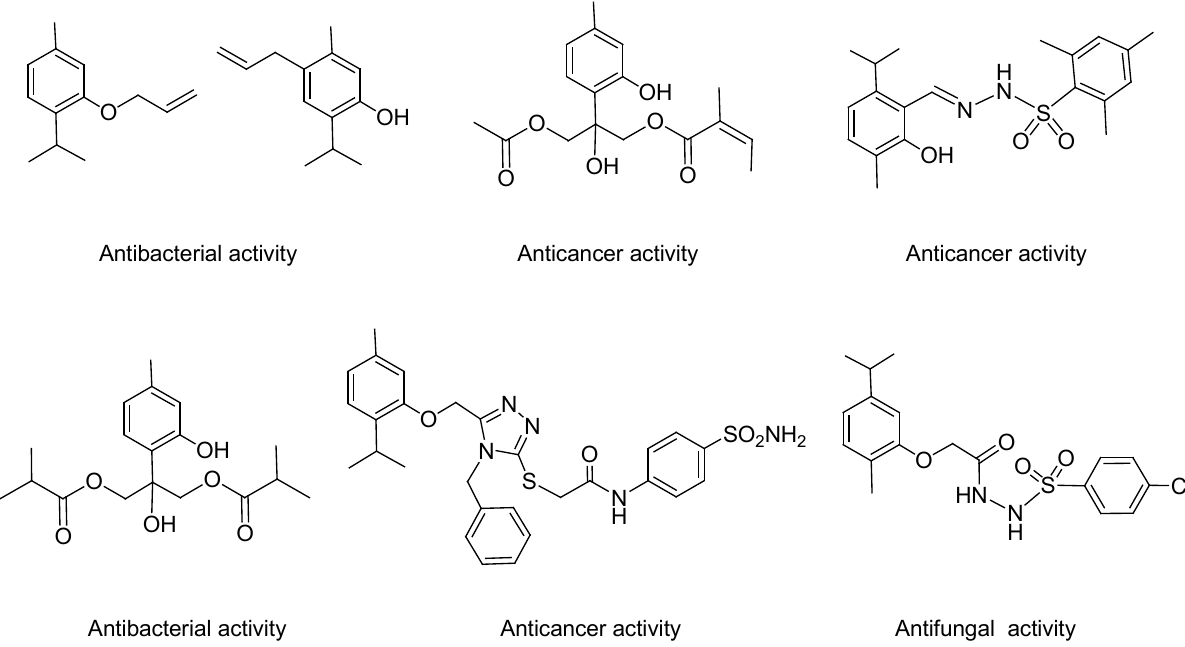
Figure 1. Known derivatives of thymol and carvacrol exhibiting antibacterial [18,22,23], anticancer [18,35–37] and antifungal [27] activities.